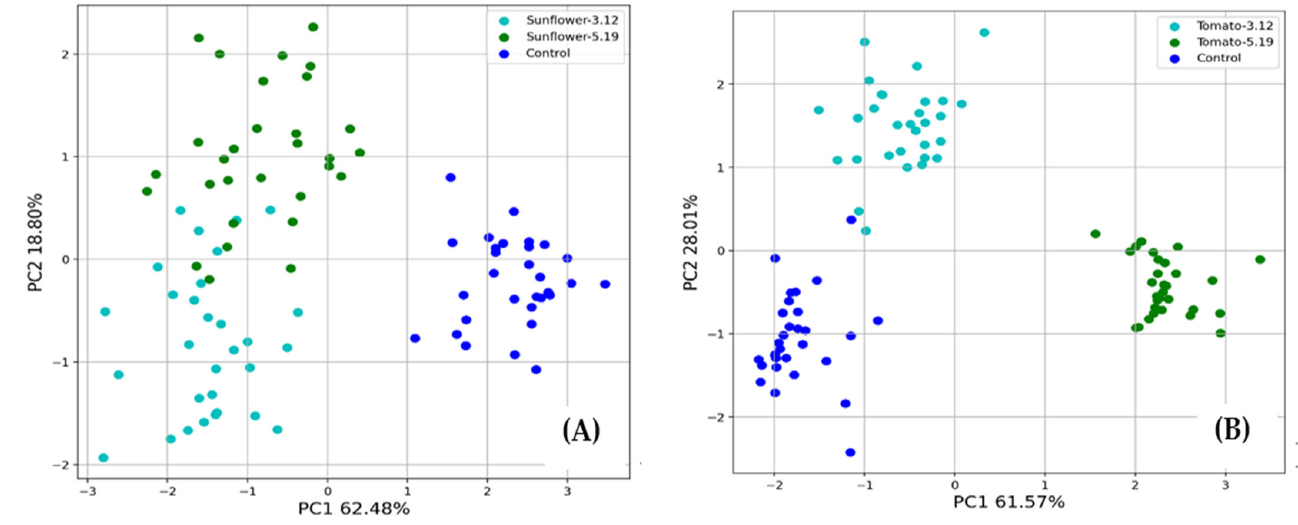
Figure 7. Clustering relationship of inoculated sunflower seeds ( A ) and tomato seeds ( B ) with isolates of Pseudarthrobacter enclensis (P-3.12) and Curtobacterium citreum (P-5.19) and co-inoculation with uninoculated control according to the PCA analysis of the growth ‐ promoting experiment.